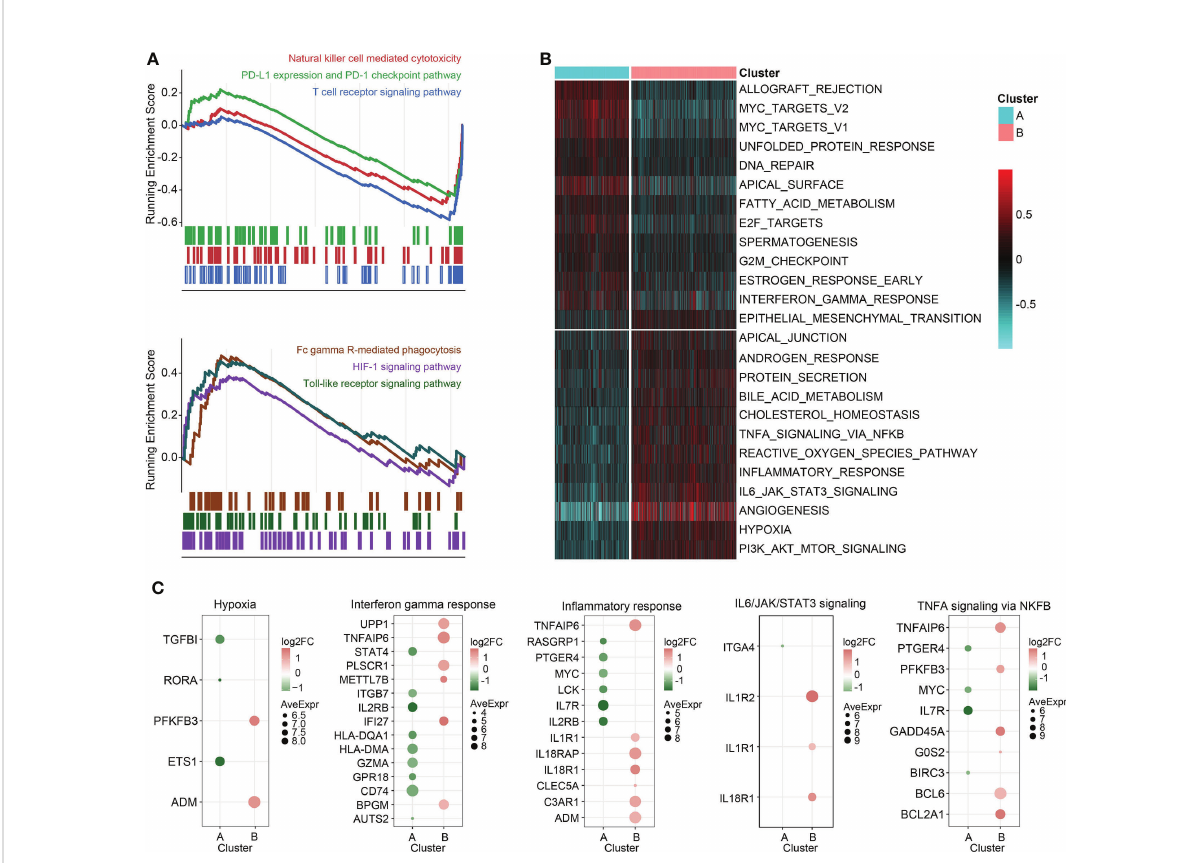
FIGURE 4 GSEA and GSVA. (A) GSEA of genesets for cluster A (top) and cluster B (bottom). (B) Heatmap of GSVA on sepsis samples grouped by K-means clusters. (C) Scatterplot of the changed pathway-related